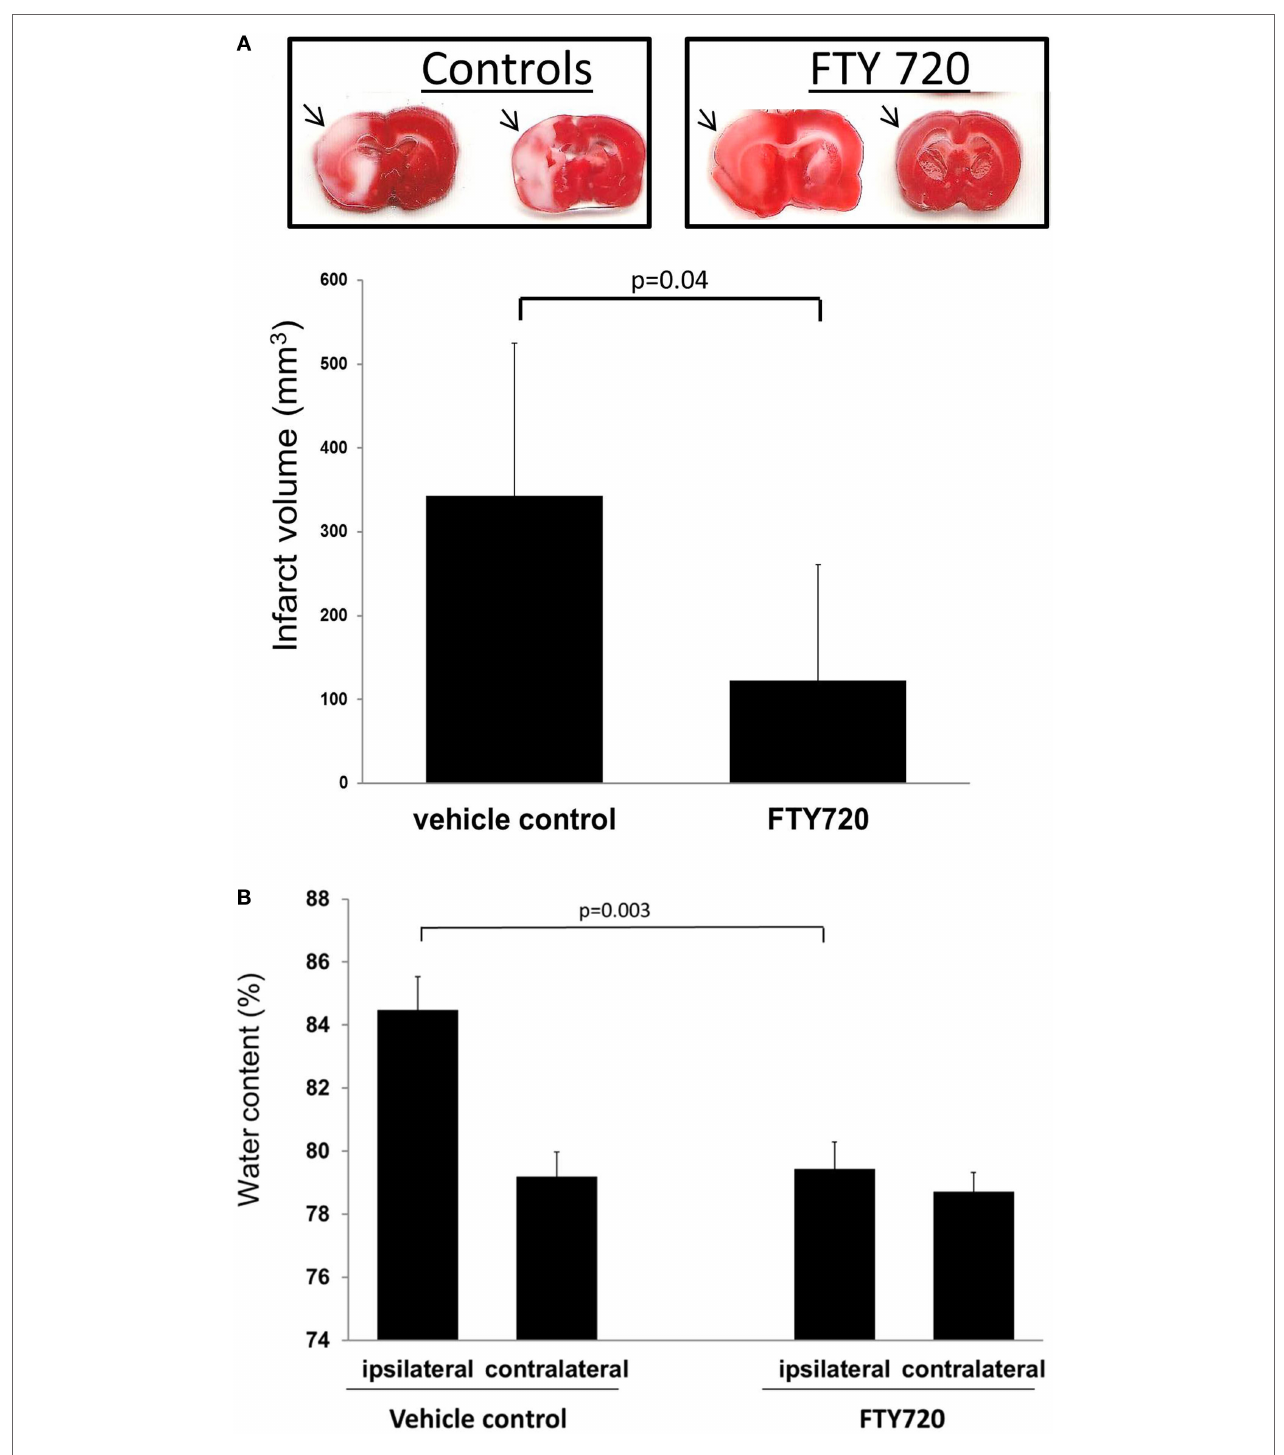
FiGUre 4 | infarct volume and brain edema in rats subjected to cerebral ischemia reperfusion . Male adult Sprague-Dawley rats were subjected to middle cerebral artery occlusion (MCAo) for 60 min followed by reperfusion. Three hours after reperfusion, animals were treated with vehicle or 0.5 mg/kg FTY720 intraperitoneally. Infarct volume was determined as previously described (56). Brain edema was determined by measuring hemispheric water content (41). (a) Representative coronal brain cuts obtained 24 h after MCAo. The arrows highlight areas of cerebral infarction. Brain cuts were digitalized and infarct volume determined by using the image analysis software (MetaMorph; Universal Imaging Corp., Downingtown, PA, USA). (B) Brain edema determined in the ipsilateral and contralateral hemisphere. Compared to vehicle animals, the treatment with 0.5 mg/kg FTY720 reduced infarct volume and brain edema. Significance determined using an unpaired t -test. Means ± SD ( n =